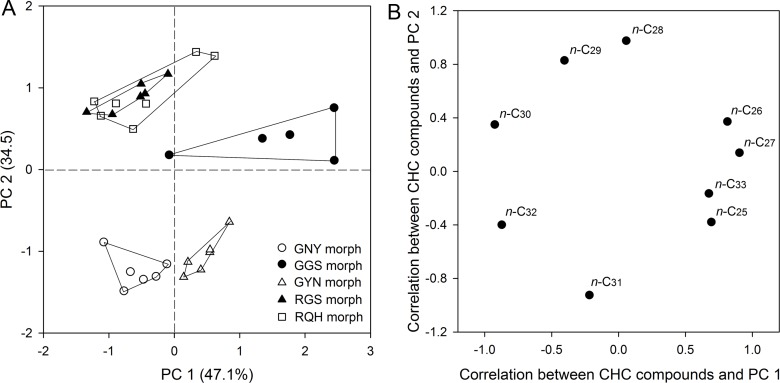
Principal components analysis (PCA) of CHC profiles of five geographic morphs of A. pisum.Wingless adults of each morph reared on V. faba were used for SPME sampling (7 μm PDMS). Shown are score plots of PC 1 versus 2, with the percentage of total variance explained by each axis denoted in parentheses. Each symbol represents an aphid individual. Data points for each morph are enclosed within a line. Factor loadings of CHC components on each PC are indicated in panel (B).